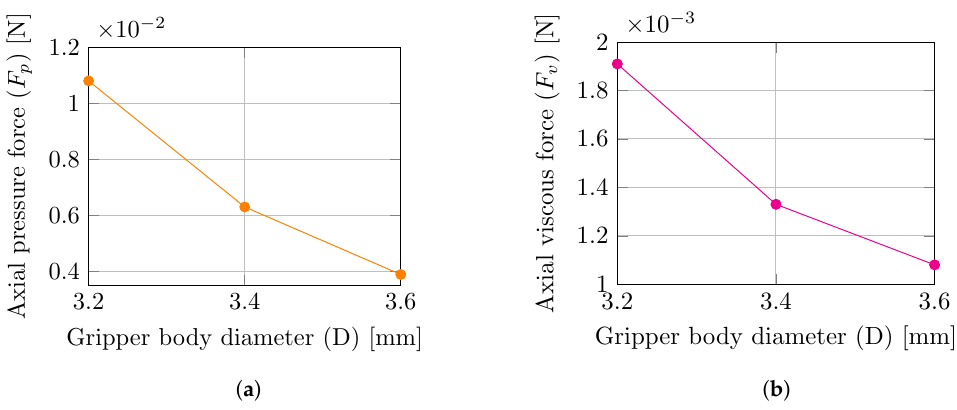
Figure 16. Dependence on gripper body diameter ( D ): ( a ) axial pressure force; ( b ) axial viscous force. Similarly, pressure force ( F P ) increases as D decreases. Since the pressure force acting on the releasing mass is related to the pressure difference acting on its two bases, ( p sx and p dx ) a possible explanation for F P trend can be found out by looking at the pressure drop in the different regions of the gripper. As can be seen from Figure 17, the pressure in the front chamber is approximately constant and equal to the pressure acting on the upstream releasing mass base ( p sx ). Considering Figure 17 where average static pressure on cross- sections versus dimensionless axial direction ( z / L tot ) is plotted, the pressure difference acting on the releasing mass ( p sx – p dx ) can be written as: